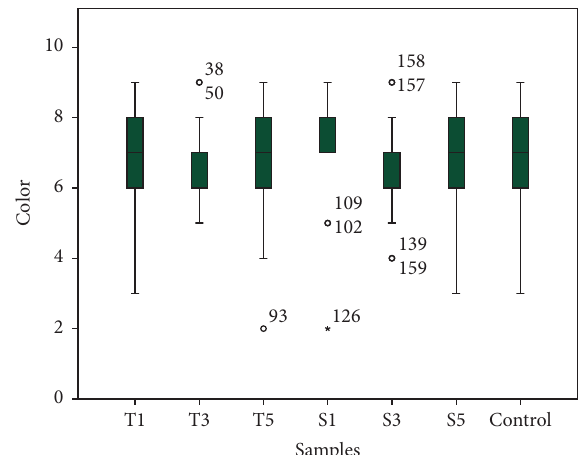
Figure 6: Box-plots obtained for the colour of prepared cake